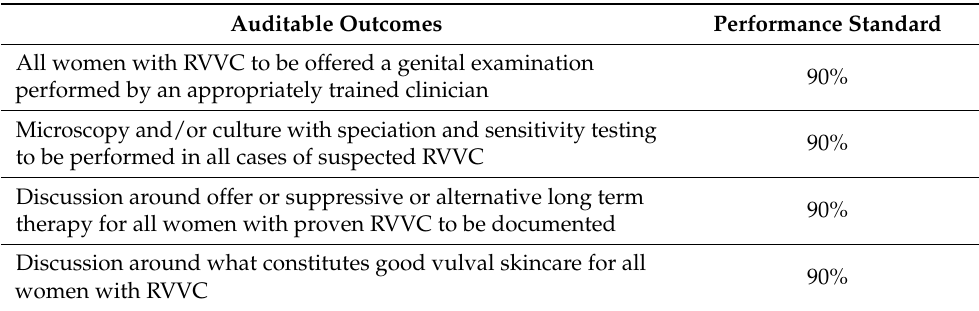
Table 2. Recommended auditable outcomes for management of RVVC [2]. Adapted with permission from the lead author Dr Cara Saxon on the behalf of the guideline writing